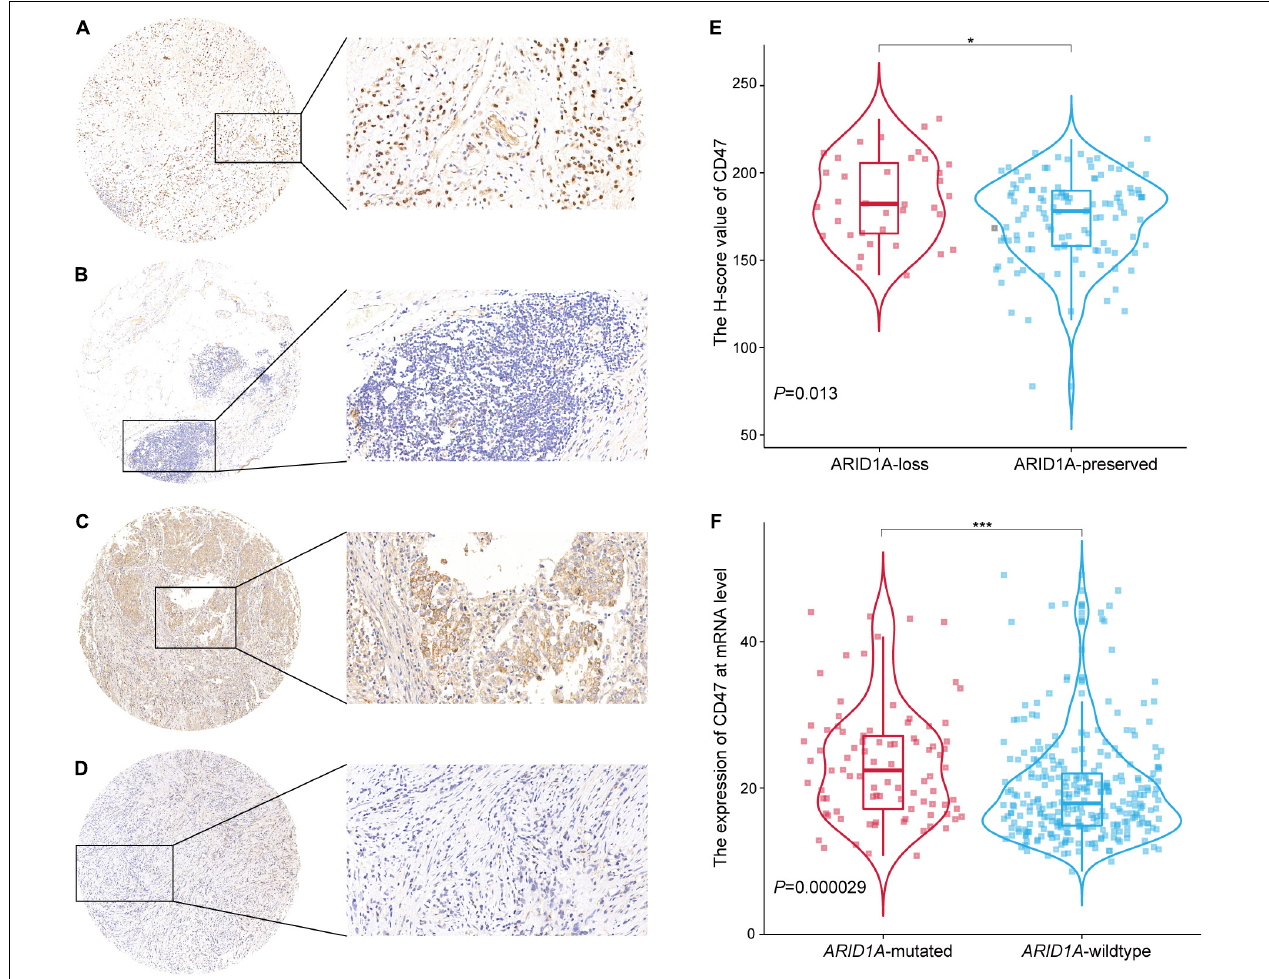
FIGURE 1 | Expression of ARID1A and CD47 and their relationship in GC tissues. (A,B) Representative IHC images of ARID1A staining, ARID1A-preserved expression (A) , ARID1A-loss expression (B) . (C,D) Representative IHC images of CD47 staining, CD47 high expression (C) , CD47 low expression (D) . (E) Relationship between loss/preserved expression of ARID1A and CD47 expression ( n = 154). (F) Relationship between mutated/wild-type expression of ARD1A and CD47 expression (data from TCGA, n = 375). * p < 0.05, *** p <